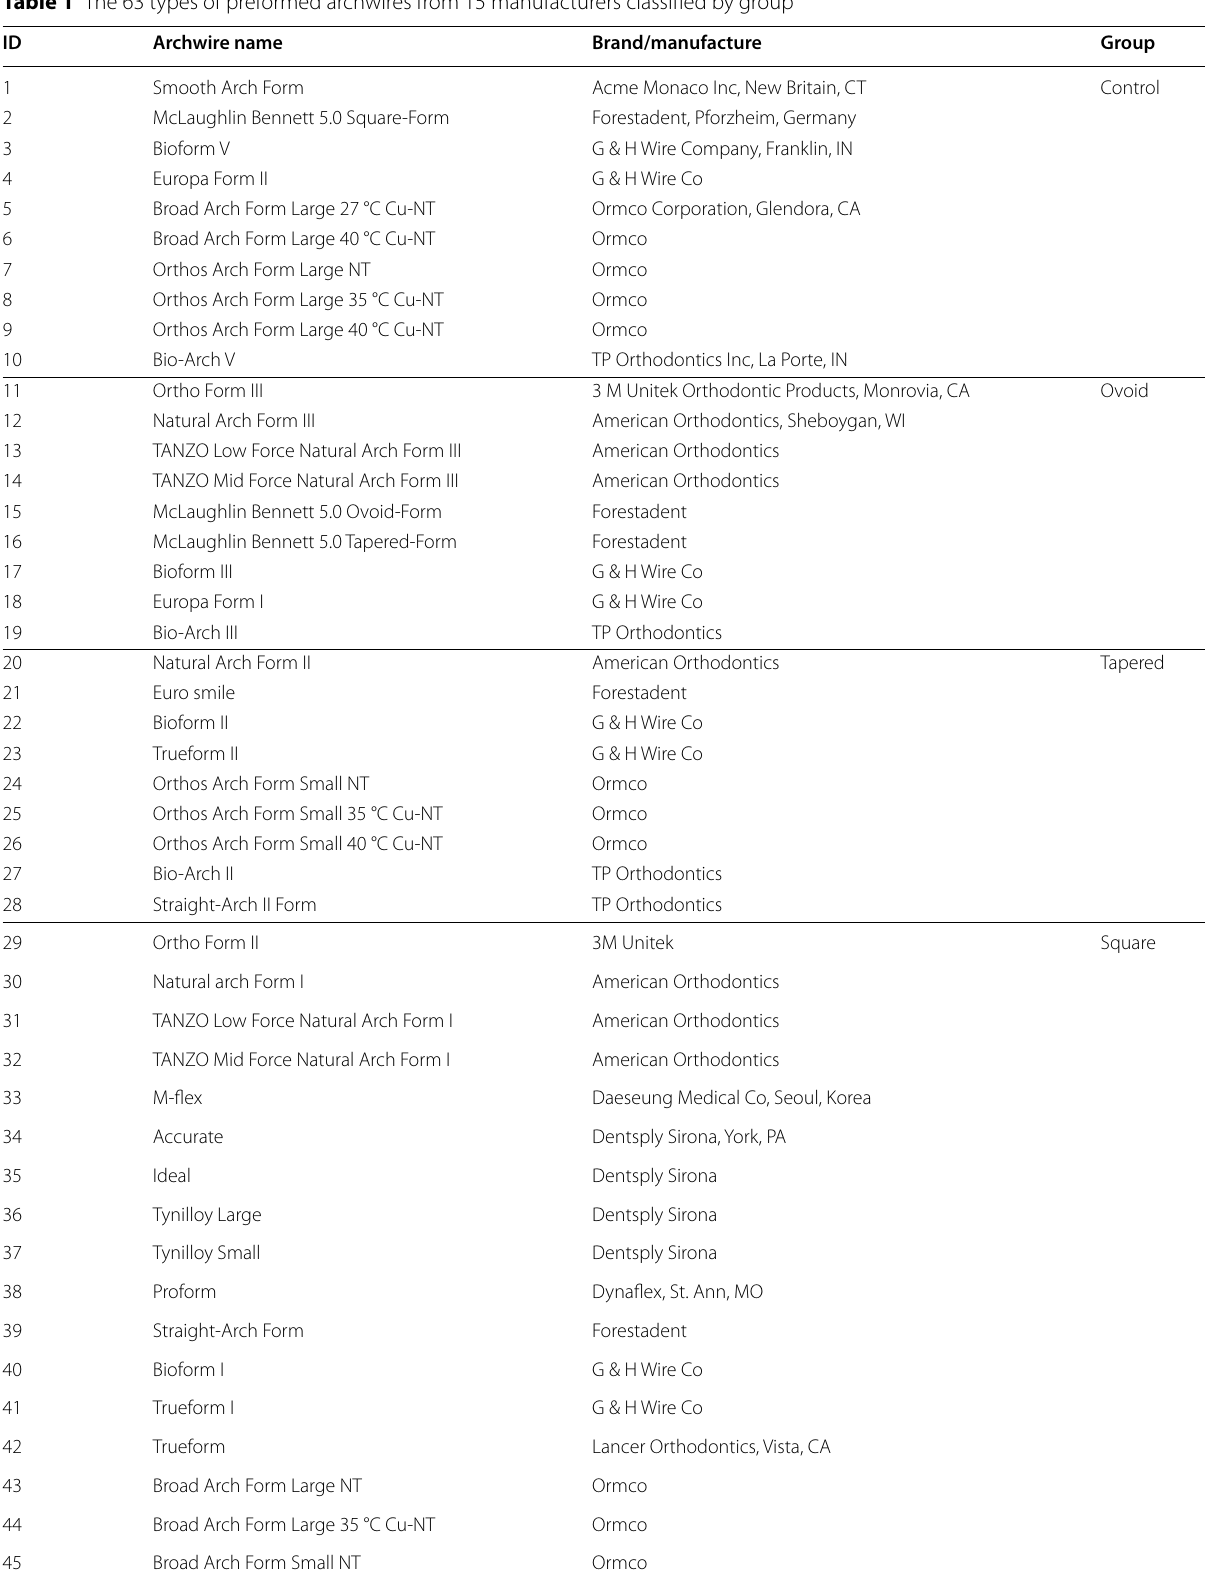
Table 1 The 63 types of preformed archwires from 15 manufacturers classified by